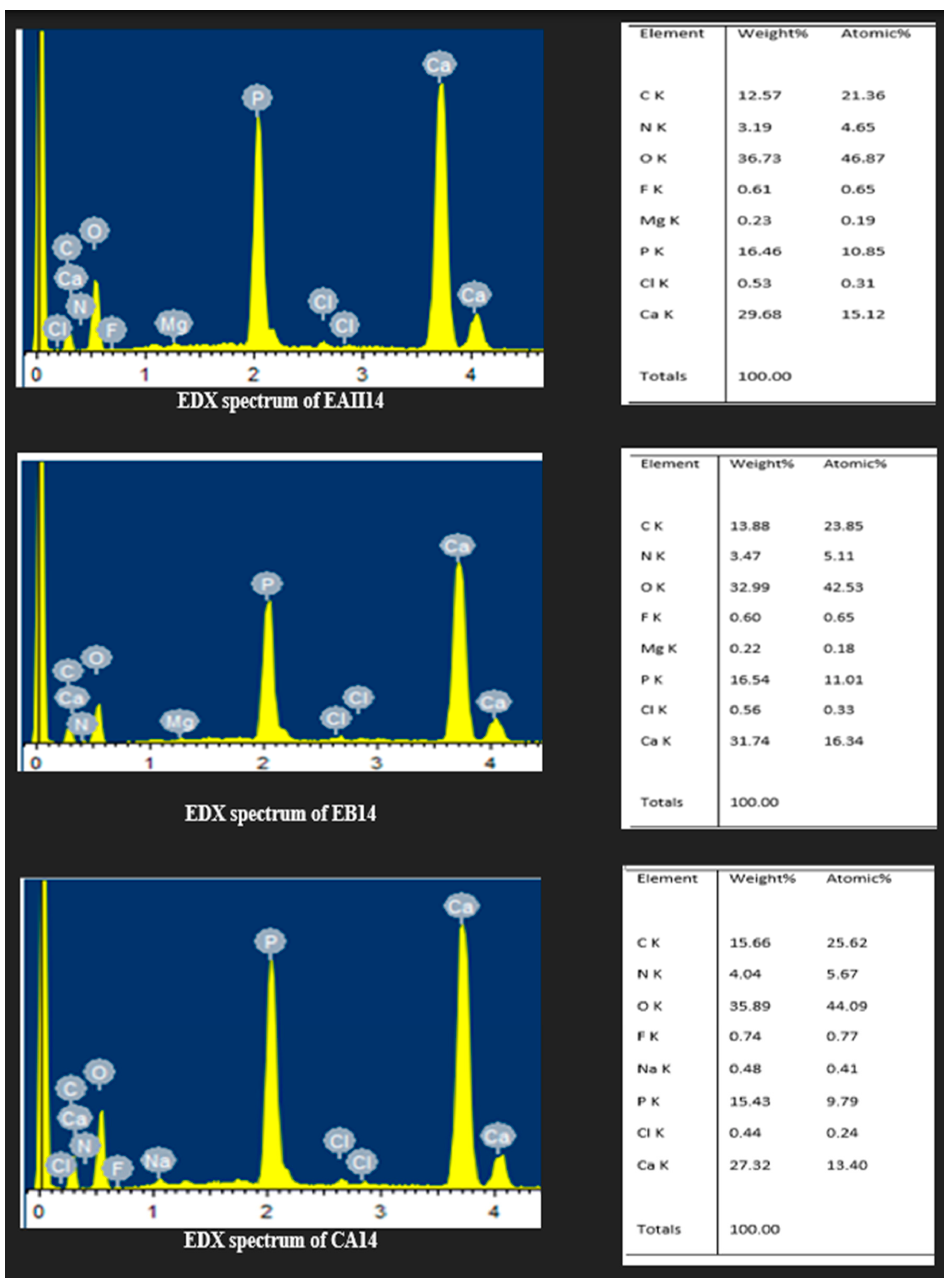
Figure 9. EDX analysis of the tooth samples of the EAII14, EB14, and CA14 groups